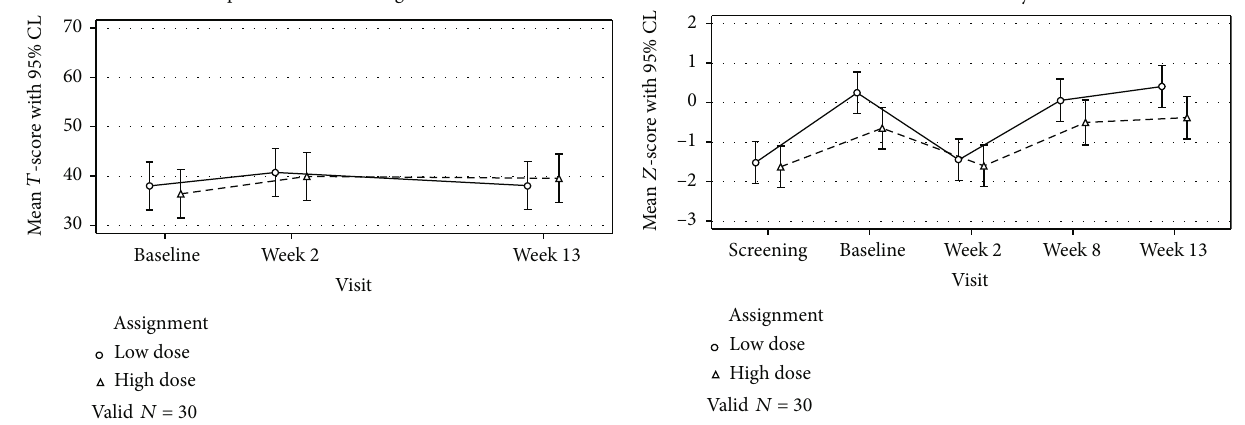
Figure 3: Language and memory functioning performance over